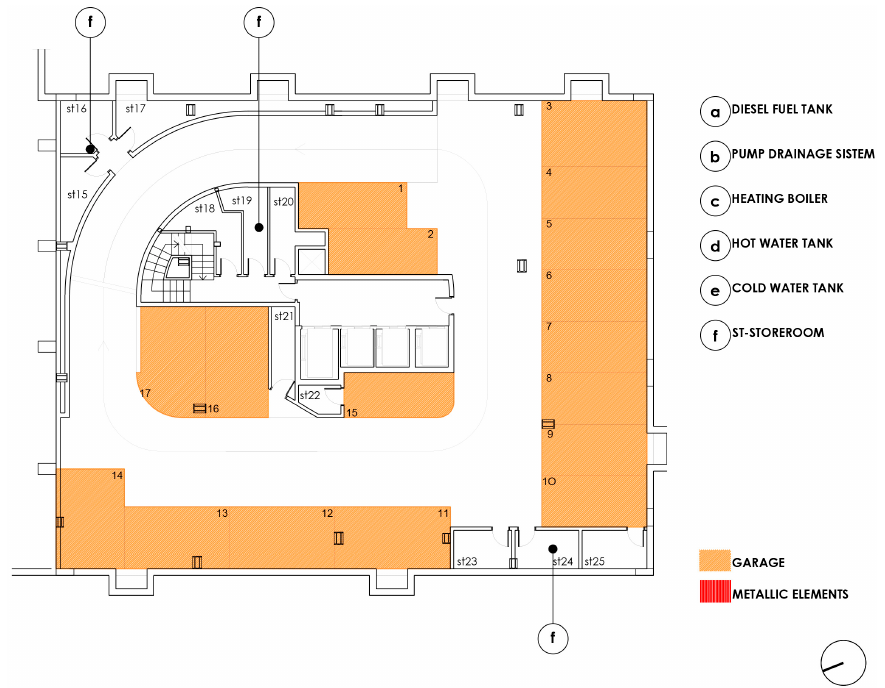
Figure 3 . Basement level − 1 plan.